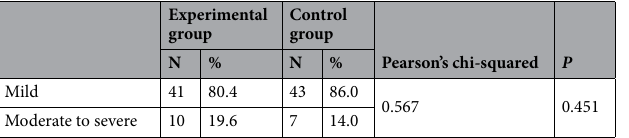
Table 5. Between-group comparison of the pain rating on day-5 of